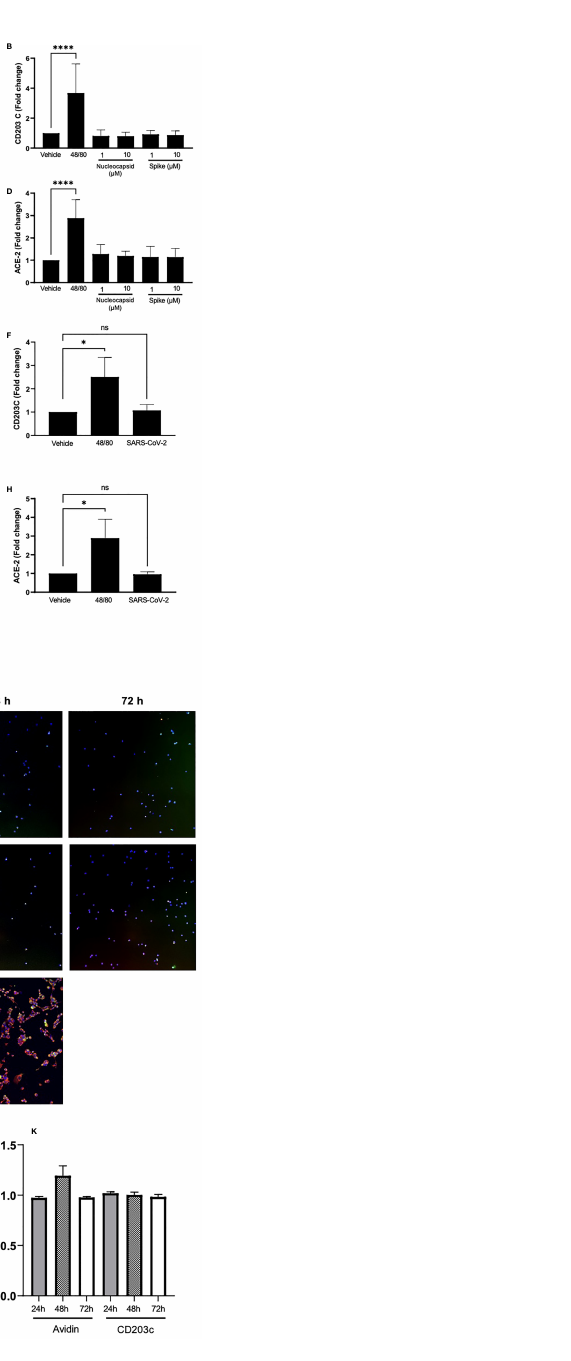
FIGURE 3 Neither viral proteins nor the SARS-CoV-2 virus directly induce MC degranulation, and SARS-CoV-2 virus does not penetrates MC. LUVA cells were cultured in the presence or absence of compound 48/80 (10 µg/ml) or spike protein or nucleocapsid protein (1-10 µM; A – D ), or SARS- CoV-2 (E – H) for 1 h in a CO 2 -free humidi fi ed atmosphere at 37°C. Cells were analyzed for the expression of (A, E) avidin, (B, F) CD203c, (C, G) CD63, or ACE-2 (D, H) using a CytoFlex fl ow cytometer and quanti fi ed using FlowJo v10. Statistical signi fi cance was determined using a one- way ANOVA with Tukey ’ s multiple comparisons test. *p<0.05, ****p<0.0001. ns, not signi fi cant. LUVA cells were incubated without or with ( fi rst and second rows, respectively) ARS-CoV-2 virus for 24 h, 48 h or 72 h, after which cells were seeded on a polylysine-coated polystyrene wells and stained for nuclei (blue), nucleocapsid protein (red), and spike protein (green) to evaluate virus entry into the cells (I) . Vero cells (third row) served as a control of both virus penetration and quality of the antibodies. No dissemination of the virus inside cells was observed at all time points, which is con fi rmed by quantitation of the fl uorescence (J) ; C and V designate control and virus for Vero cells. Staining of cell samples for avidin and CD203c revealed no degranulation (K) . Scale bar 200 um, n = 3 for each time